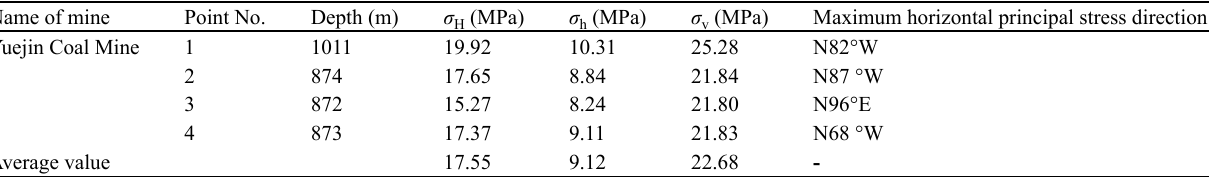
Table 1 Ground stress test results in Yuejin Coal Mine